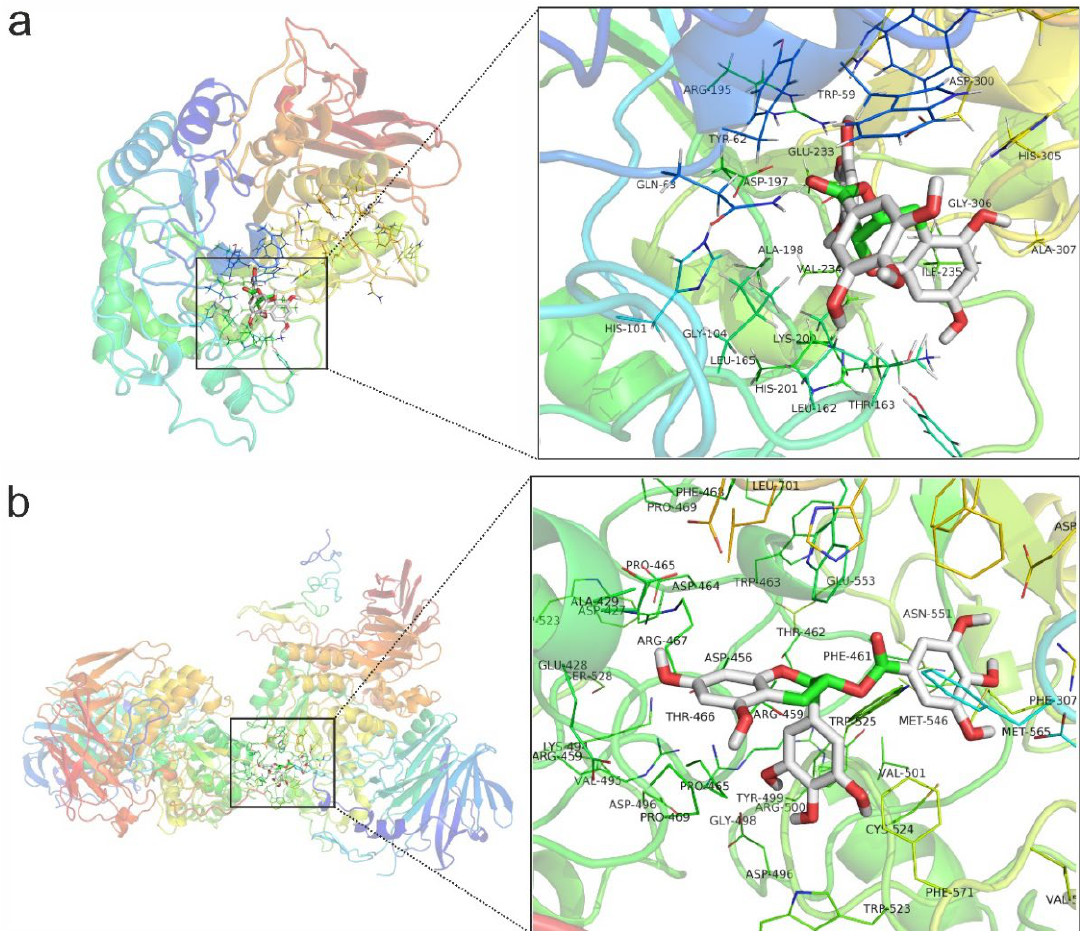
Figure 3. The interactions of EGCG with α -amylase ( a ) and α -glucosidase ( b ) computationally simulated by AutoDock Vina with the lowest docking affinity. α -amylase and α -glucosidase are shown in cartoon form. The detailed view showed the adjacent residue of the binding site in the active pocket, labeled with amino acid and the corresponding sequence number.